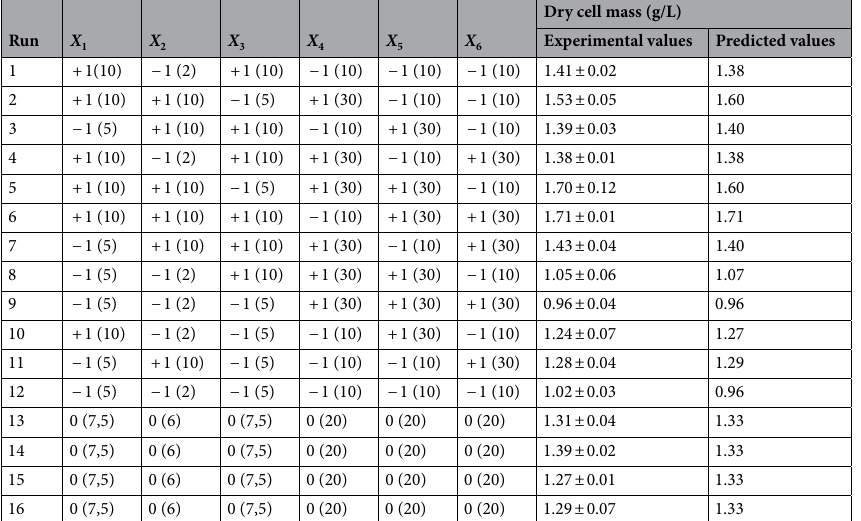
Table 1. Experimental matrix of the Plackett–Burman design for biomass production of L. sakei ACU-2. X 1 Yeast extract (g/L); X variable. The dry cell mass was measured after 24 h of incubation. Data are presented as the mean value of independent experiments performed in triplicate and the standard